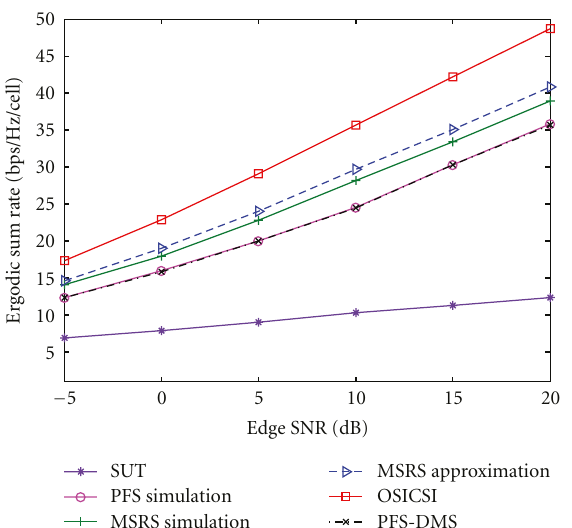
Figure 4: Comparison of average sum rate versus edge SNR for B = 3, K = 30, N t = 4, and N r = 2.